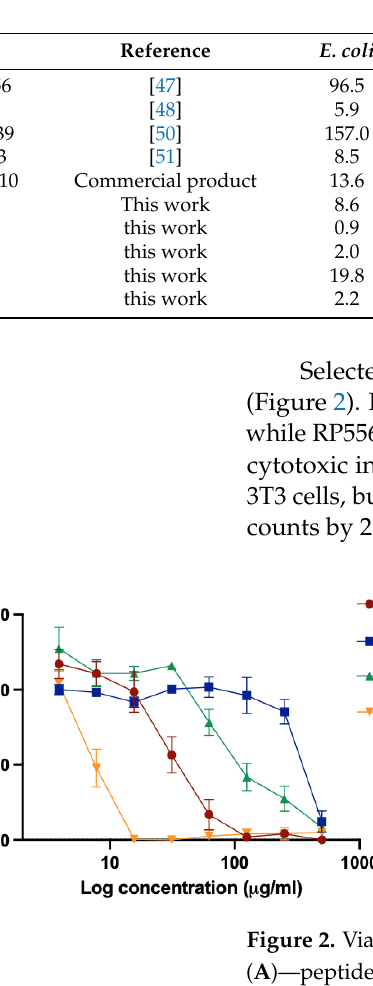
Table 4. Therapeutic indexes of antimicrobial peptides. Calculations done based on cytotoxicity (IC 50 ) in human primary dermal fibroblast cell line and MIC values against listed bacteria.